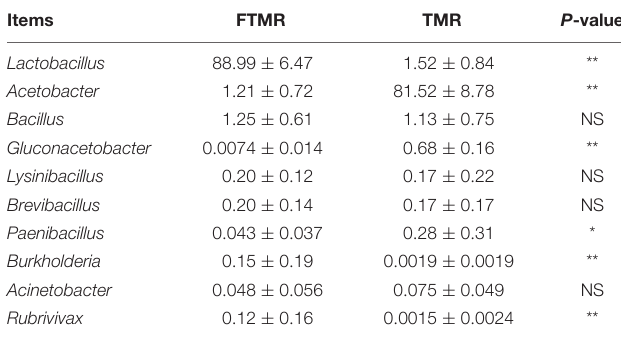
TABLE 4 | Relative abundance (%) of 10 most predominant genera in fermented or non-fermented